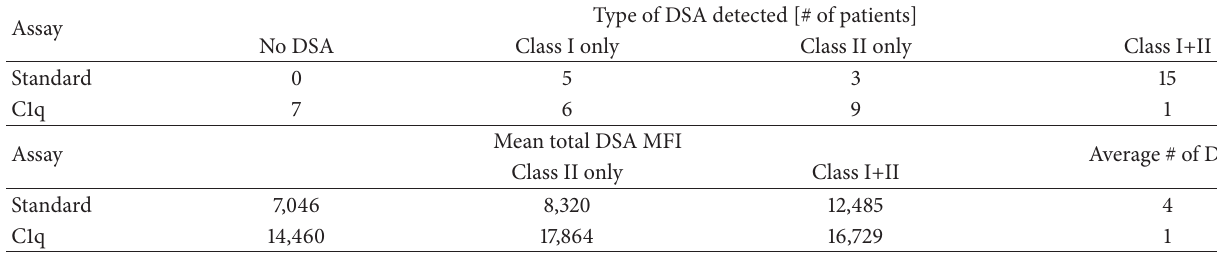
Table 8: DSA, IgG subclasses, and C1q detection in C4d+ patients.